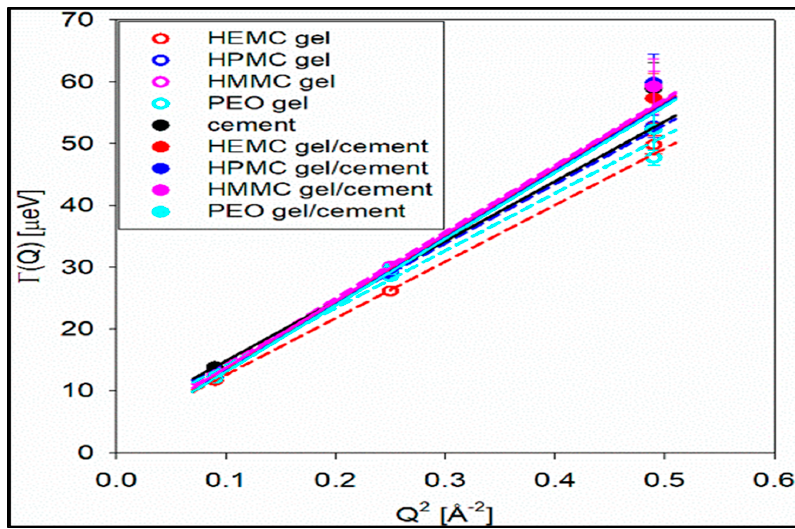
Figure 10. Plot of Lorentzian HWHM versus Q 2 for all samples. Table 1. Diffusion coefficients obtained from fit of the HWHM for DQ 2 + offset.